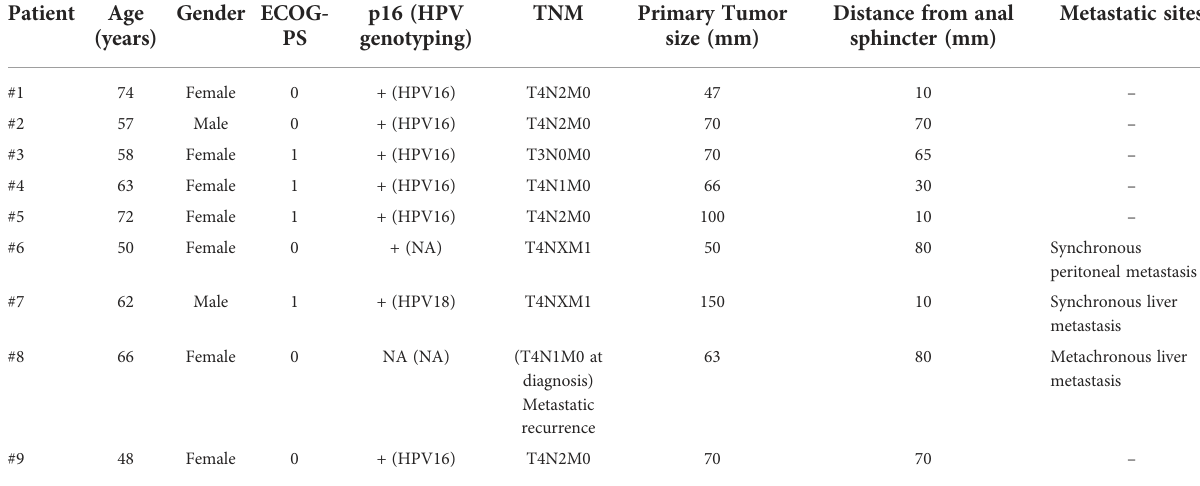
TABLE 4 Patient characteristics before mDCF